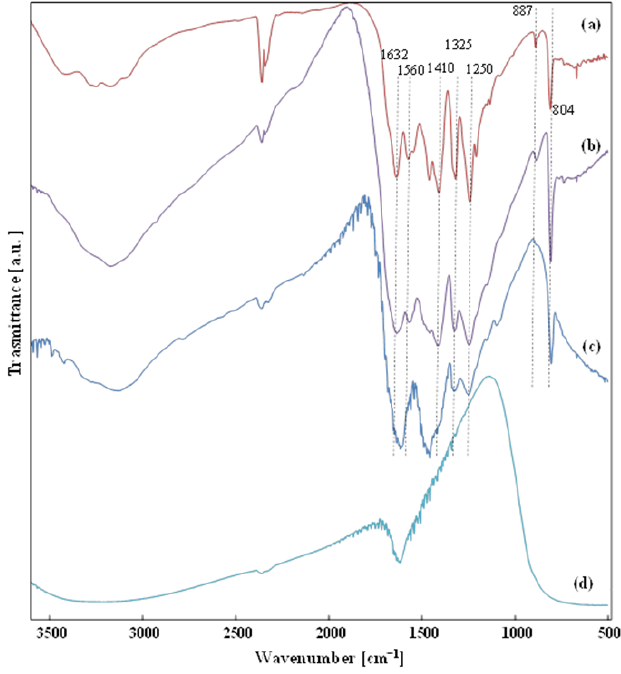
Figure 3. FTIR spectra of ( a ) C 3 N 4 -TE, ( b ) TiO 2 -exCl/TE, ( c ) P25/TE, and ( d ) bare TiO 2 -exCl. Figure 3 also shows a broad band ranging from 3500 to 3000 cm −1 , which can be at- tributed to O-H and N-H stretching, due to the presence of hydroxyl adsorbed species and free amino groups on the surface. The N-H stretching confirms the existence of NH and/or NH 2 groups caused by the incomplete polycondensation of the C 3 N 4 [32]. The IR transitions attributed to the heptazine heterocyclic ring are less defined and wider in the composites, indicative of a disorder in the carbon nitride layered structure after the ball milling process in the presence of both titania-containing samples. This is particularly true for the P25/TE sample, for which the SEM micrographs evidenced a uniform coverage of C 3 N 4 by the titania nanoparticles. In Figure 3, the FTIR of the bare TiO 2 exCl sample is also shown, evidencing the absence of bands in the heptazine range, the presence of water, and the transitions due to the cut-off at ca. 900 cm −1 due to the Ti-O-Ti bonds in the oxide sample. The band gap energy Eg of the catalysts was obtained according to the Tauc equation and the Tauc plots (see Figure 4). The Eg values are reported in Table 1. According to the band gap calculations, the addition of carbon nitride to the P25 has a positive effect on the Eg of the catalyst, lowering its value and extending the absorption of radiation towards the visible range. A similar trend can be observed for TiO 2 exCl/TE.